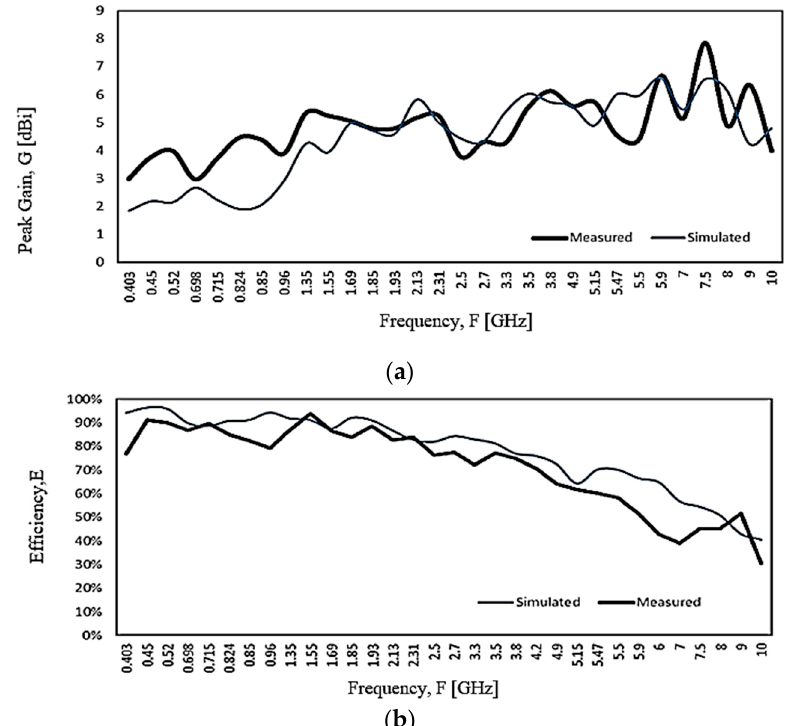
Figure 26. Simulated and measured azimuth (theta 90°/ X-Y) plane radiation pattern of the proposed antenna from 350 MHz to 10,000 MHz.